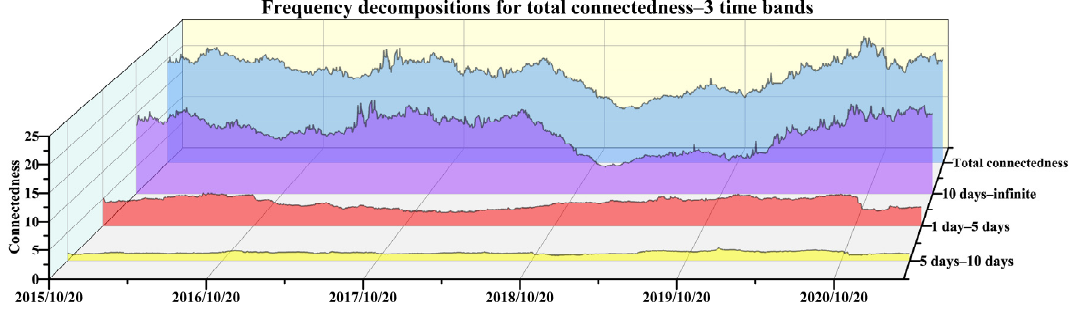
Figure 5. Total demand connectedness and frequency decomposition with three time bands.